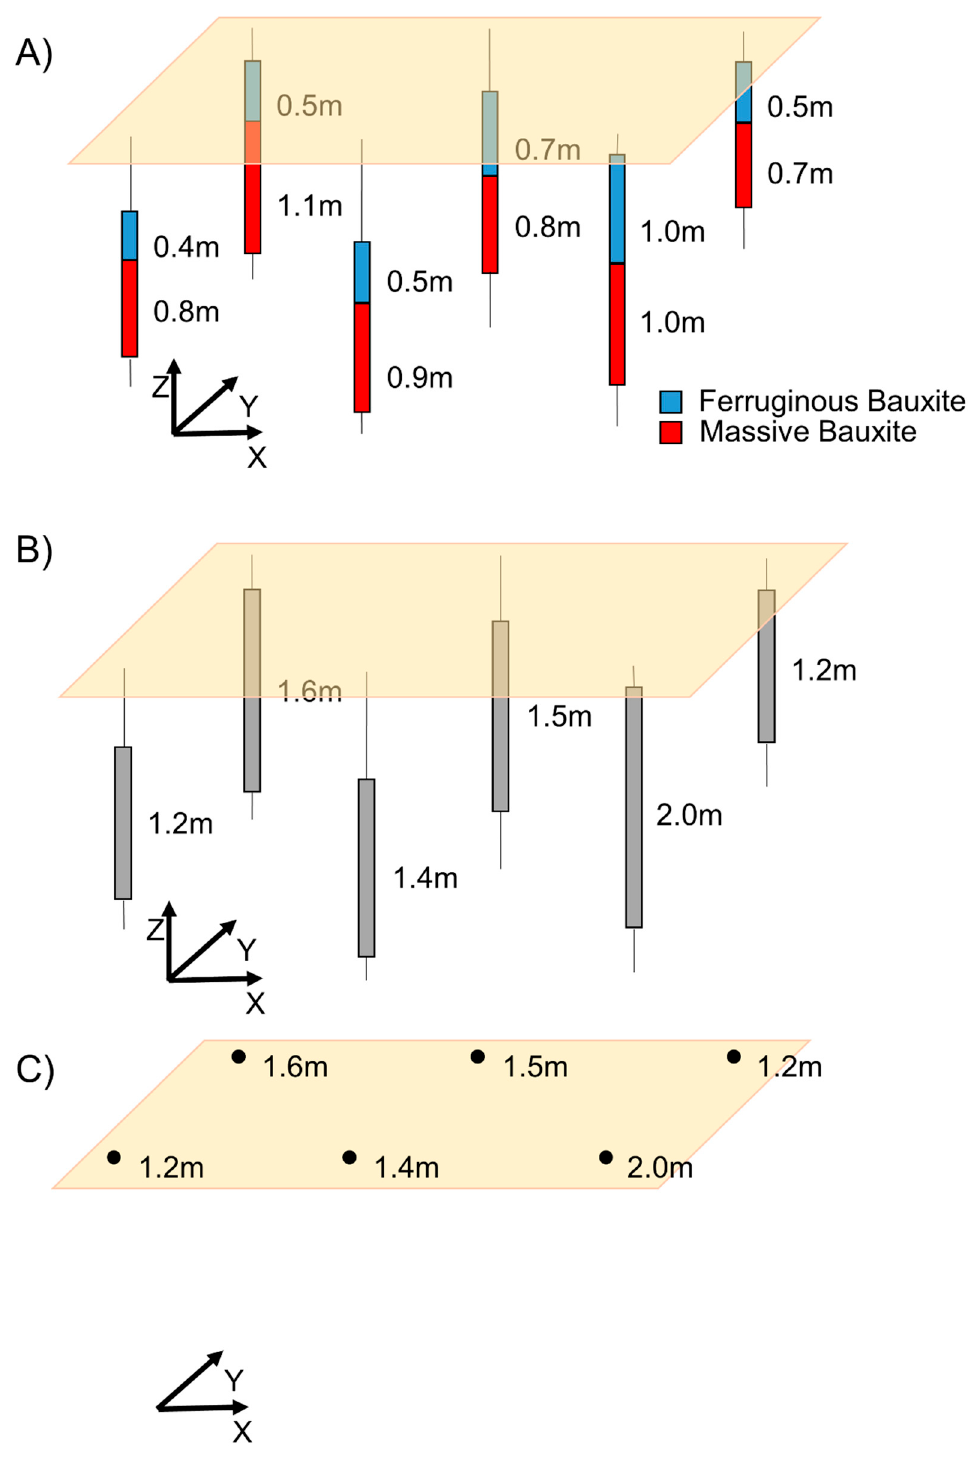
Figure 4. Step-by-step workflow for ( A ) selecting ore thickness intervals, ( B ) accumulating these intervals, and ( C ) converting 3D databases (intervals) to 2D (points).